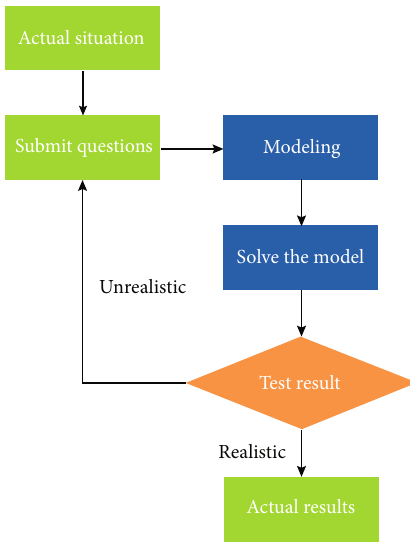
Figure 1: The basic process of mathematical modeling activities.